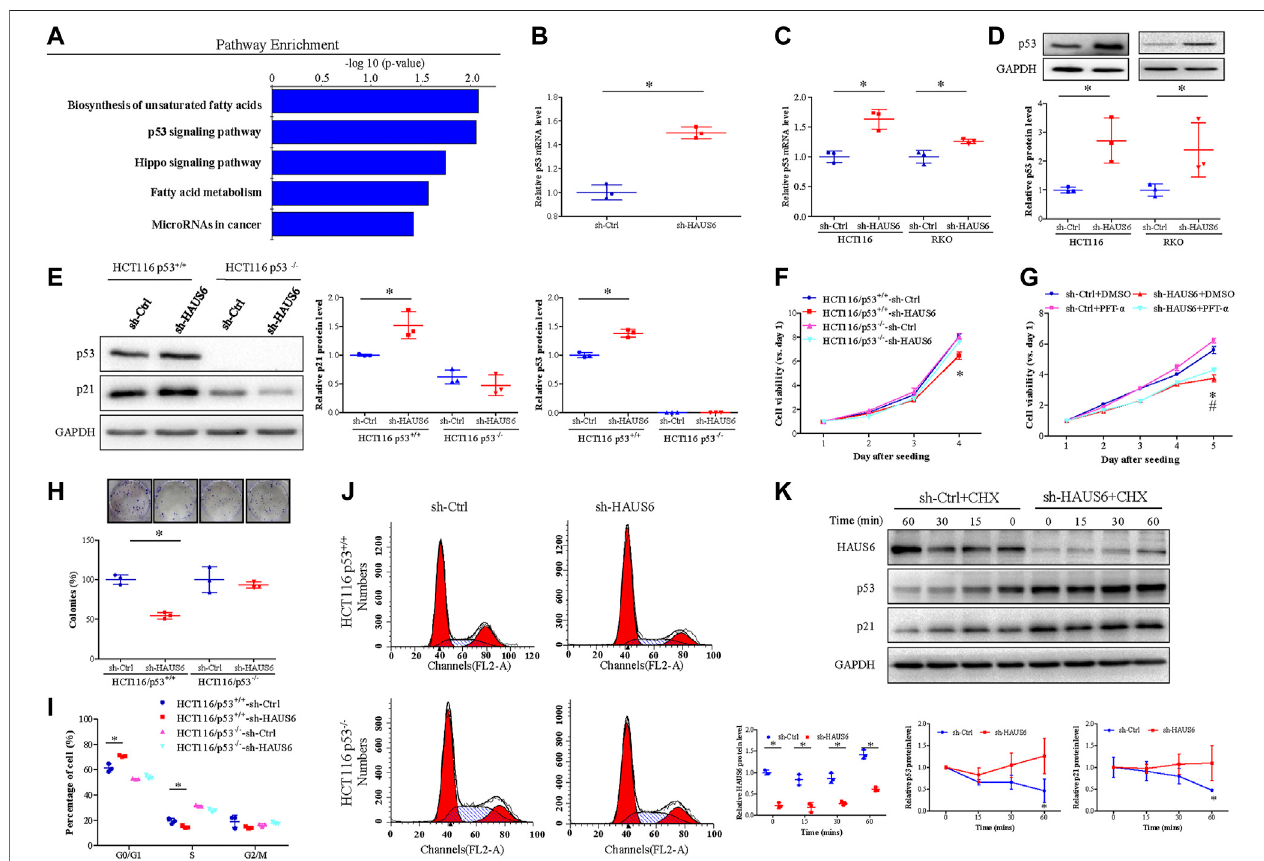
FIGURE 6 | HAUS6 knockdown inhibits cell proliferation by activating the p53/p21 pathway. (A) The top fi ve pathways enriched in DEGs was identi fi ed by KEGG pathway enrichment analysis (all p < 0.05). (B-C) TP53 mRNA levels in cells transduced with shRNA against HAUS6 or control shRNA was assessed by (B) microarray (HCT116cells) and (C) quantitative RT-PCR (HCT116 andRKOcells).Mean ± SD; n (cid:1) 3;* p < 0.05,vs. sh-Ctrl,byindependent Student ’ s t test. GAPDHwasusedasan internalcontrol. (D) Proteinlevelsofp53inHCT116 and RKOcellsafter HAUS6knockdownwasdetected bywesternblot. GAPDHwasusedasaloadingcontrol. Band intensities werequanti fi ed using ImageLab software. Mean ± SD; n (cid:1) 3; * p < 0.05, vs. sh-Ctrlby independent Student ’ s t test. (E) Proteinlevelsofp53 inHCT116/ p53 +/+ andHCT116/p53 − / − cellsafterHAUS6knockdown wasassessed bywesternblot.GAPDHwasused asaloadingcontrol.Band intensitieswerequanti fi edusing ImageLab software. Mean ± SD; n (cid:1) 3; * p < 0.05, vs. sh-Ctrl ofHCT116/p53 +/+ cells, by independent Student ’ s t test. (F) Viability of HCT116/p53 +/+ cells and HCT116/ p53 − / − cellstransducedwithshRNAagainstHAUS6orcontrolshRNA.Resultswerenormalizedtoviabilityonday1.Mean ± SD;n (cid:1) 6;* p < 0.05,vs.sh-CtrlofHCT116/ p53 +/+ cells, by independentStudent ’ s t test. (G) Cell viability in HCT116 cells treated with p53 inhibitor. Results were normalized to viability on day 1. Mean ± SD; n (cid:1) 6; * p < 0.05, vs. sh-Ctrl and # p < 0.05, vs. sh-HAUS6+DMSO by one-way ANOVA with LSD post hoc test. (H) Survival of HCT116/p53 +/+ cells and HCT116/p53 − / − cells transduced with shRNA against HAUS6 or control shRNA. Representative images of colonies are shown in the upper panel. Cell survival was normalized relative to the sh-Ctrl group. Mean ± SD; n (cid:1) 3; * p < 0.05, vs. sh-Ctrl of HCT116/p53 +/+ cells, by independent Student ’ s t test. (I – J) Cell cycle distribution of HCT116/p53 +/+ and HCT116/p53 − / − cells transduced with shRNA against HAUS6 or control shRNA were determined by FACS analysis, (I) the representative fl ow cytometry plots were shown. (J) The percentages of cells in G0/G1, S, and G2/M phases were analyzed. Mean ± SD; n (cid:1) 3; * p < 0.05, vs. sh-Ctrl of HCT116/p53 +/+ cells, by independent Student ’ s t test. (K) HAUS6,p53andp21protein levelsinRKOcellstransducedwithshRNAagainstHAUS6orcontrolshRNAaftercycloheximide(CHX)treatmentwas determined by western blot (n (cid:1) 3). GAPDH was used as a loading control. Band intensities were quanti fi ed using ImageLab software. Mean ± SD; n (cid:1) 3; * p < 0.05, vs. sh-Ctrl; by independent Student ’ s t